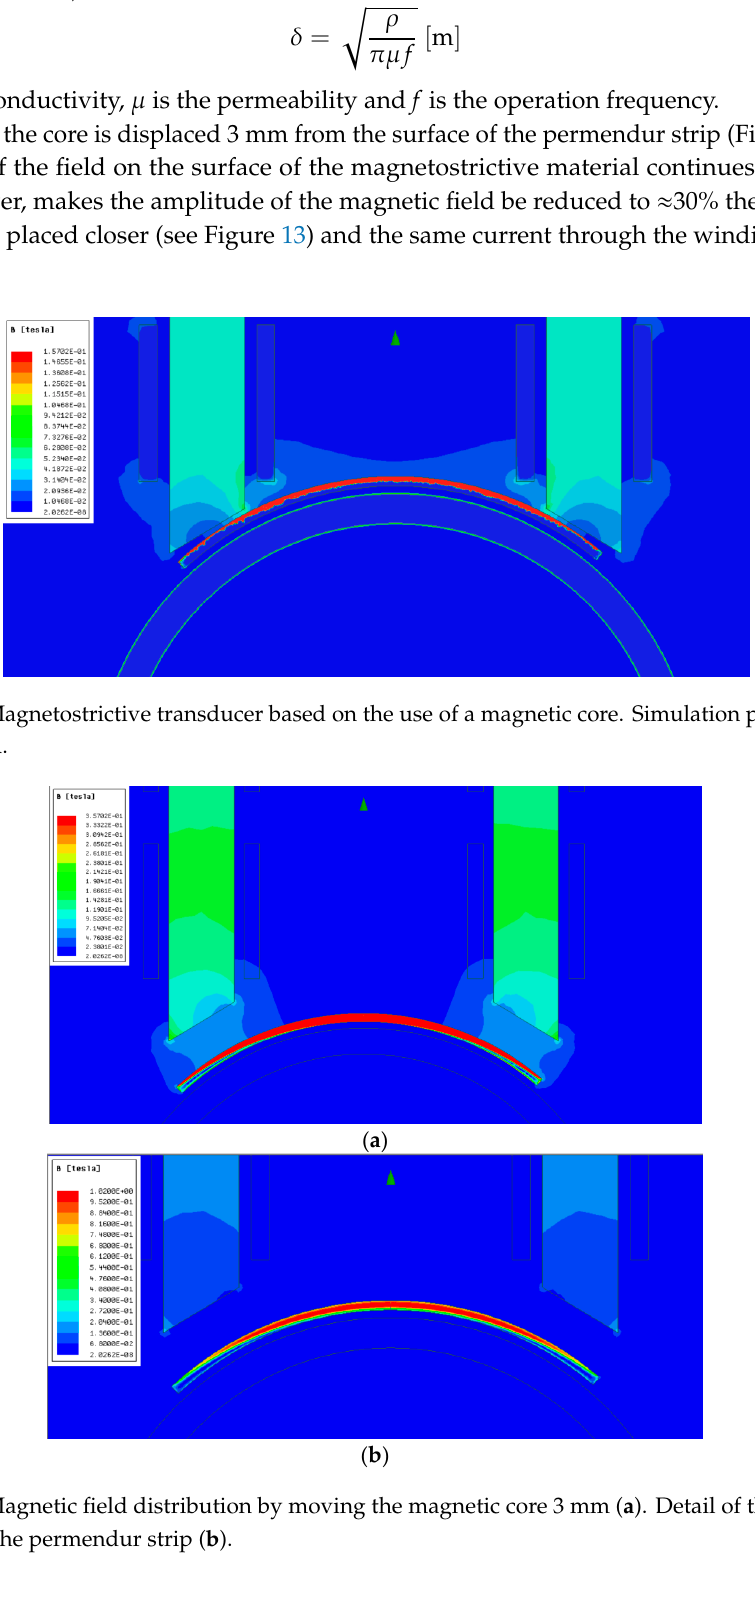
Figure 13. Magnetostrictive transducer based on the use of a magnetic core. Simulation performed at 0 Hz and 5 A. Maximum magnetic field in the core ( a ) and permendur ( b ).